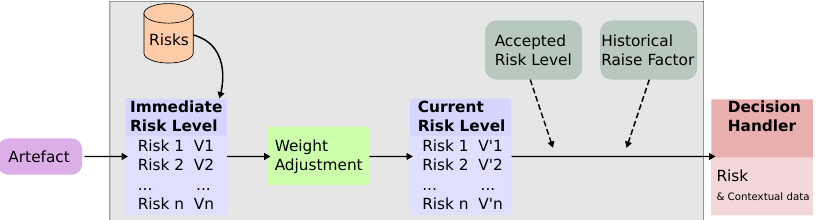
Figure 8. Risk Level